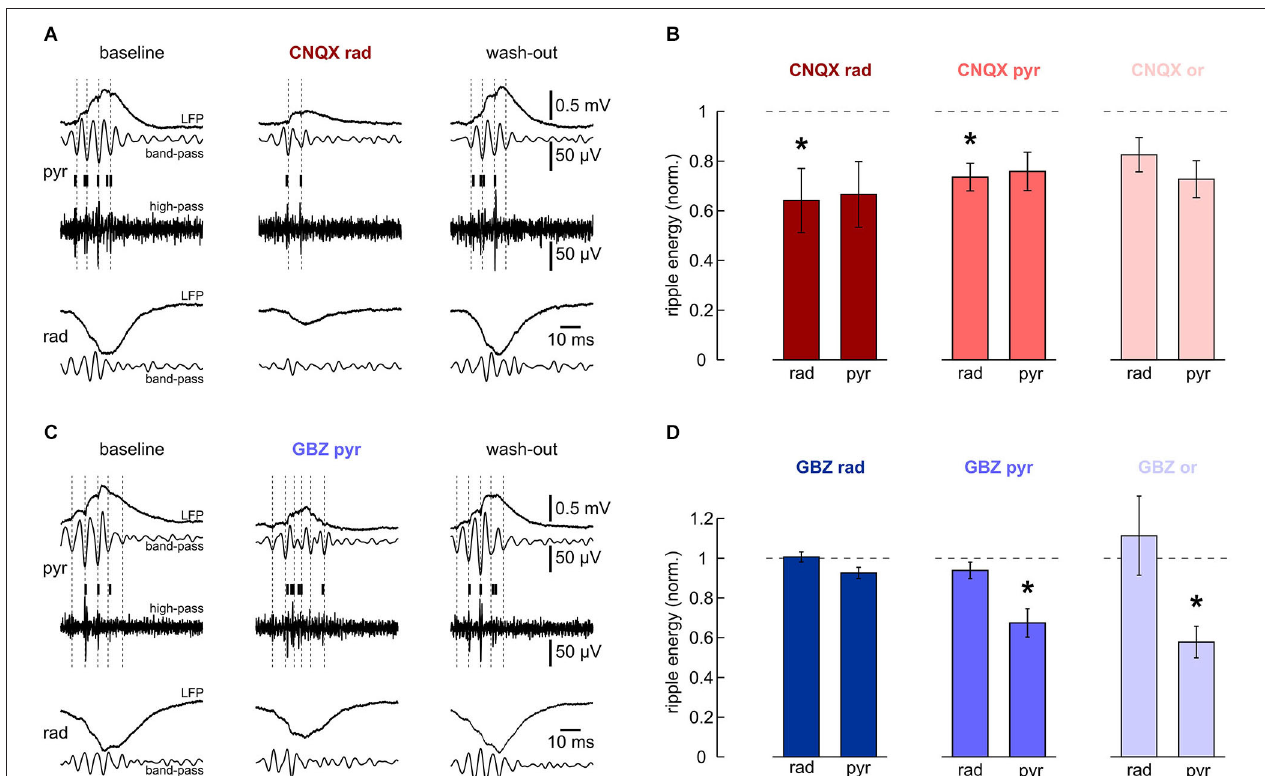
comparisons test, s. pyramidale: P > 0.05, Dunn’s multiple comparisons test). (C, D) Local application of gabazine to s. pyramidale or s. oriens reversibly inhibits ripples in the pyramidal layer. Note that ripple energy in s. radiatum is not affected. (C) Representative LFP recordings, band-pass and high-pass filtered, from s. pyramidale (upper traces) and s. radiatum (lower). Detected units are indicated by vertical bars. (Left) baseline, (middle) after 40 min of local wash-in, (right) after 60 min wash-out. (D) Normalized ripple energy in s. radiatum and s. pyramidale after local application of gabazine to (left) s. radiatum ( n = 11 slices; s. radiatum: P > 0.1, s. pyramidale: P > 0.05), (middle) s. pyramidale ( n = 6 slices; s. radiatum: P > 0.1, s. pyramidale: P < 0.01), and (right) s. oriens ( n = 8 slices; s. radiatum: P > 0.1, Wilcoxon matched-pairs signed-ranks test, s. pyramidale: P <